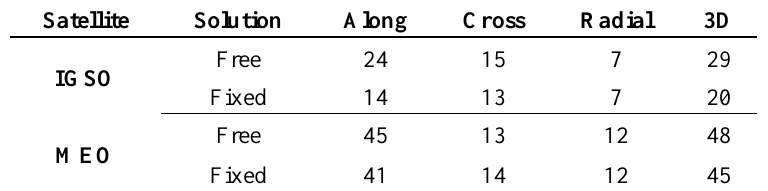
Table 8. Orbit RMS for IGSO and MEO satellites of free and fixed solutions, unit is cm.